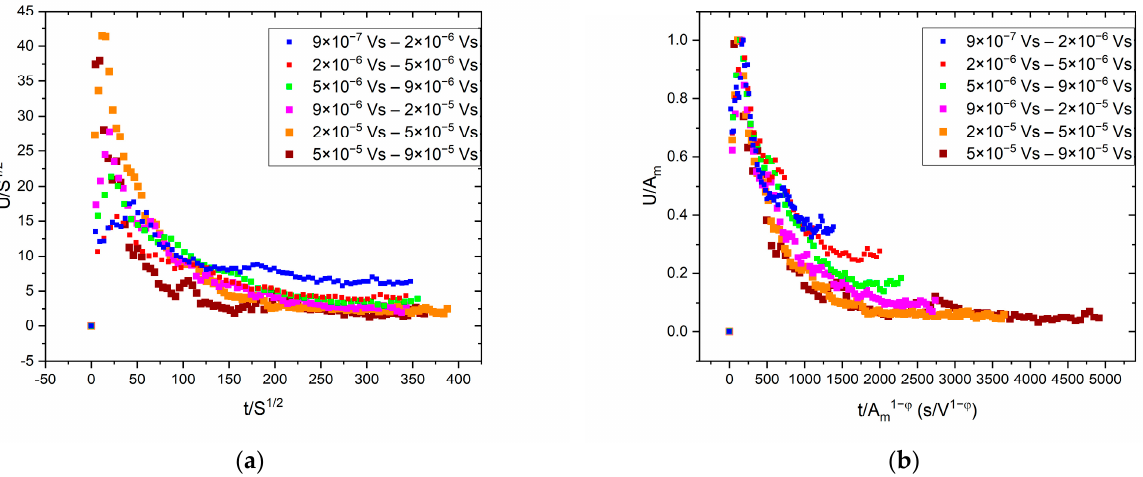
Figure 1. Average temporal shapes of AE avalanches for various fixed avalanche size ranges. ( a ): U/S 1/2 vs. t/S 1/2 ; ( b ): U/A vs. t/A 1 −φ .